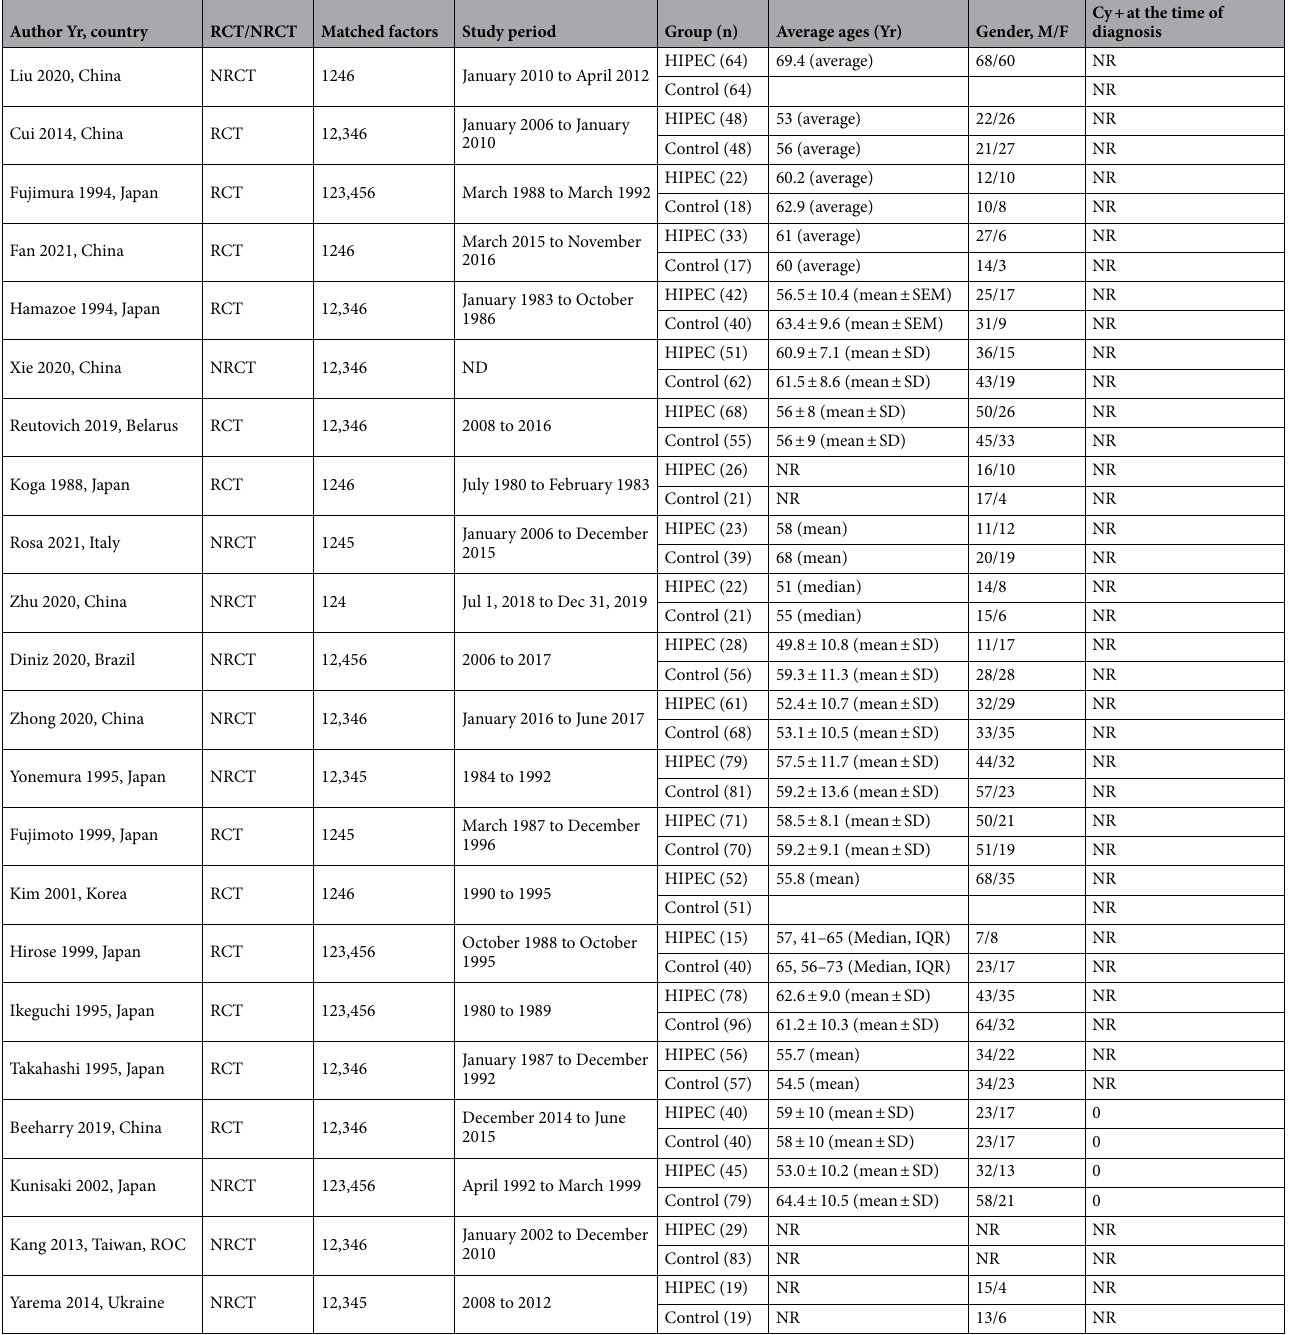
Table 2. Summary of the characteristics of patients in 22 eligible studies. HIPEC hyperthermic intraperitoneal chemotherapy, RCT randomized control trial, NRCT Non-Randomized Controlled Trial, ND not declared, M male, F female, IQR interquartile range, SD standard deviation, SEM Standard Error of Mean, Yr year, Matching: 1, age; 2, gender; 3, histology; 4, stage; 5, lymphadenectomy; 6, type of